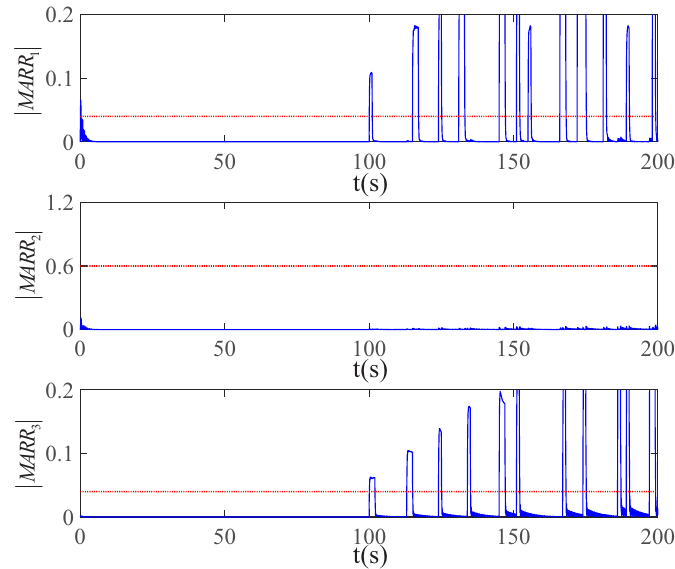
Figure 5. Residual responses under β U